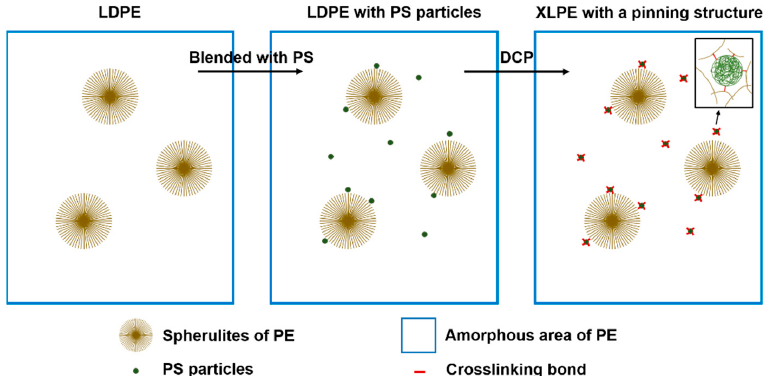
Figure 9. A sketch of XLPE with a polystyrene (PS) pinning structure.